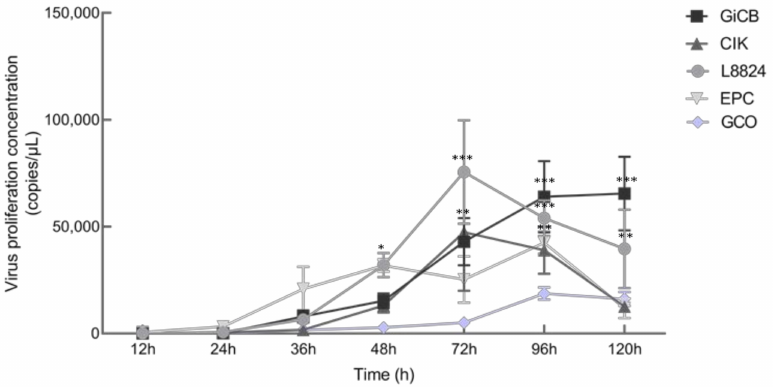
Figure 8. The changes in RNA replication levels in different cell lines infected with HGCRV. HGCRV, healthy grass carp reovirus. * p < 0.05, ** p < 0.01, *** p < 0.001.